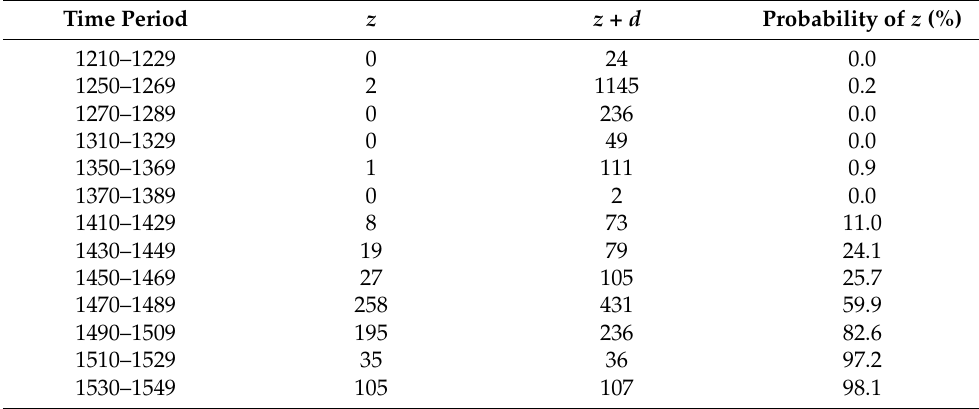
Table 4. Replacement of preconsonantal coda d by z (e.g., juzgo for judgo ).